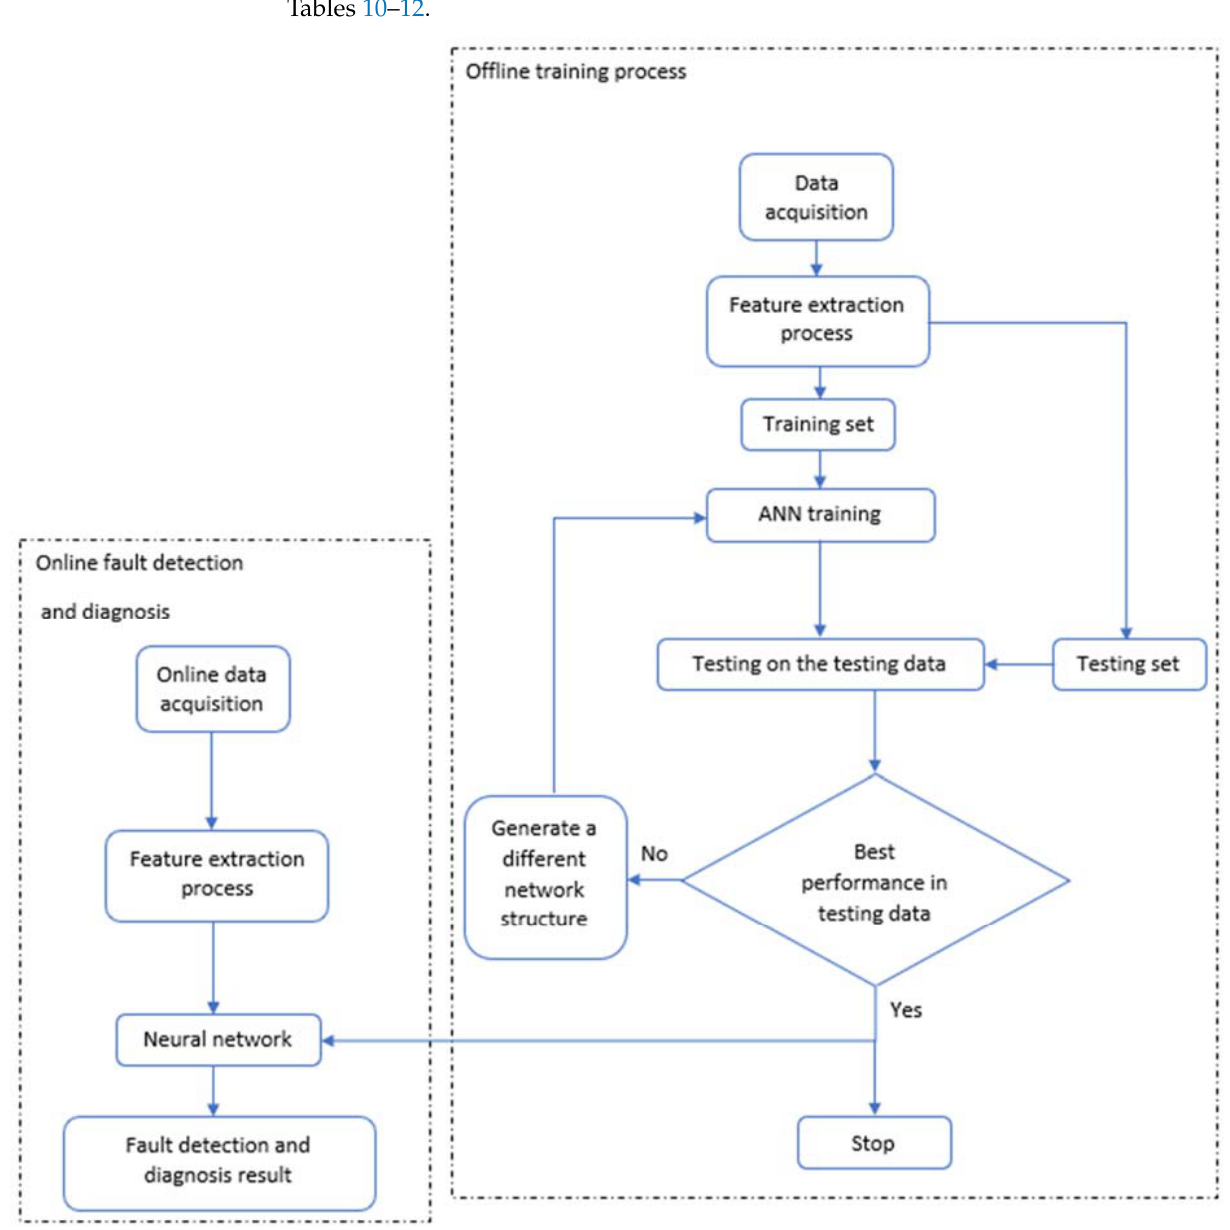
Figure 4. A typical ANN based condition monitoring system.